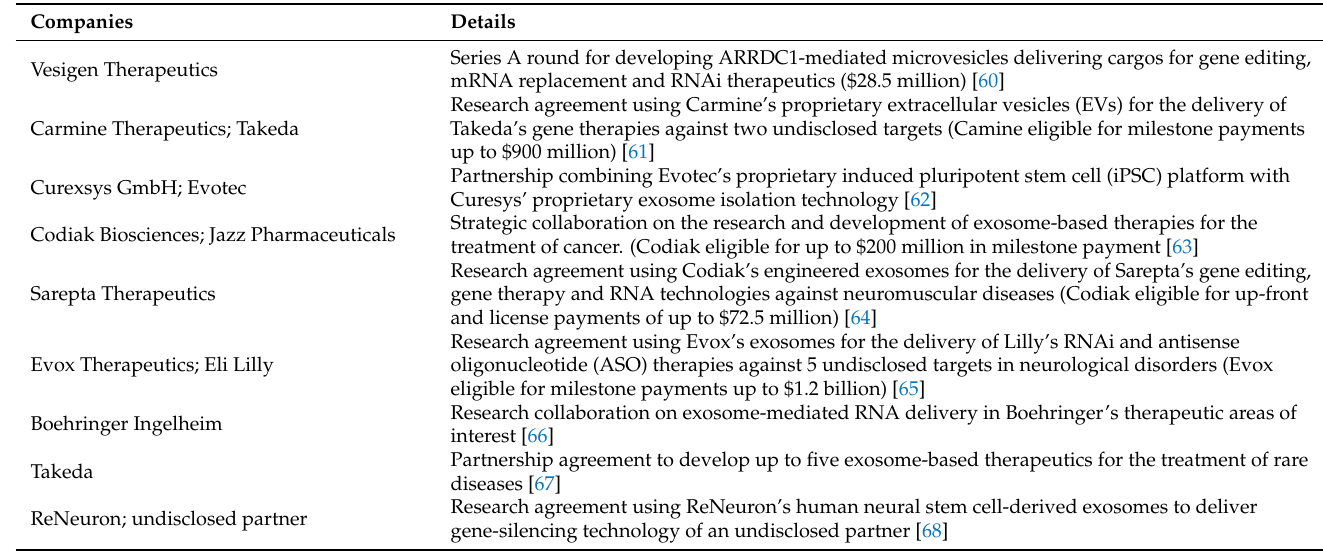
Table 4. Business Deals Between Exosome Companies and Big Pharma (from [59],